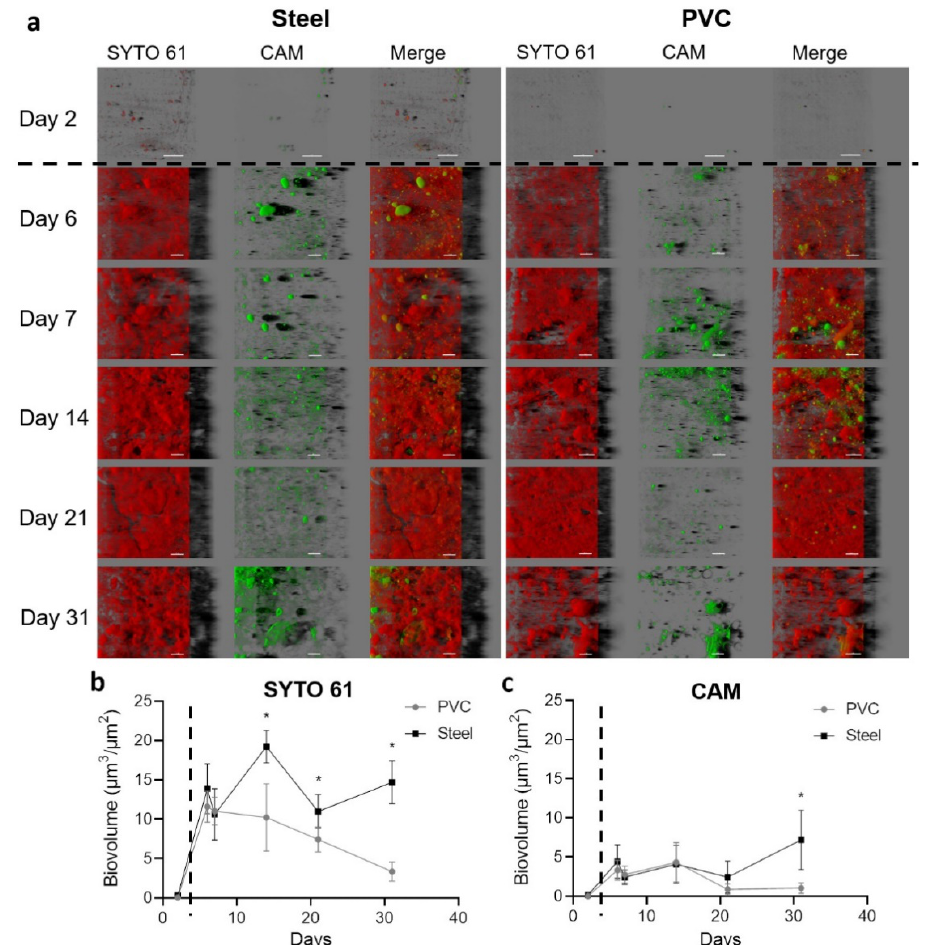
Figure 3. Confocal laser scanning microscopy visualization of biofilms settled on the steel and PVC coupons. Microorganisms and eDNA were labeled in red with SYTO61 and metabolically active cells in green with CAM. The easy 3D representative projections for each time point for steel and PVC coupons are shown ( a ). Day 2 corresponds to the first sampling, two days after the deposit of the coupons without animals in the farm; the scale bar represents 30 µm for day 2 and 40 µm for the other time points. The biovolume of SYTO 61 ( b ) and CAM ( c ) signals were extracted over time on PVC (grey lines) and steel (black lines). The dotted line indicates the animal’s entry into the building. Results represent average ±CI 95% ( * p < 0.05).